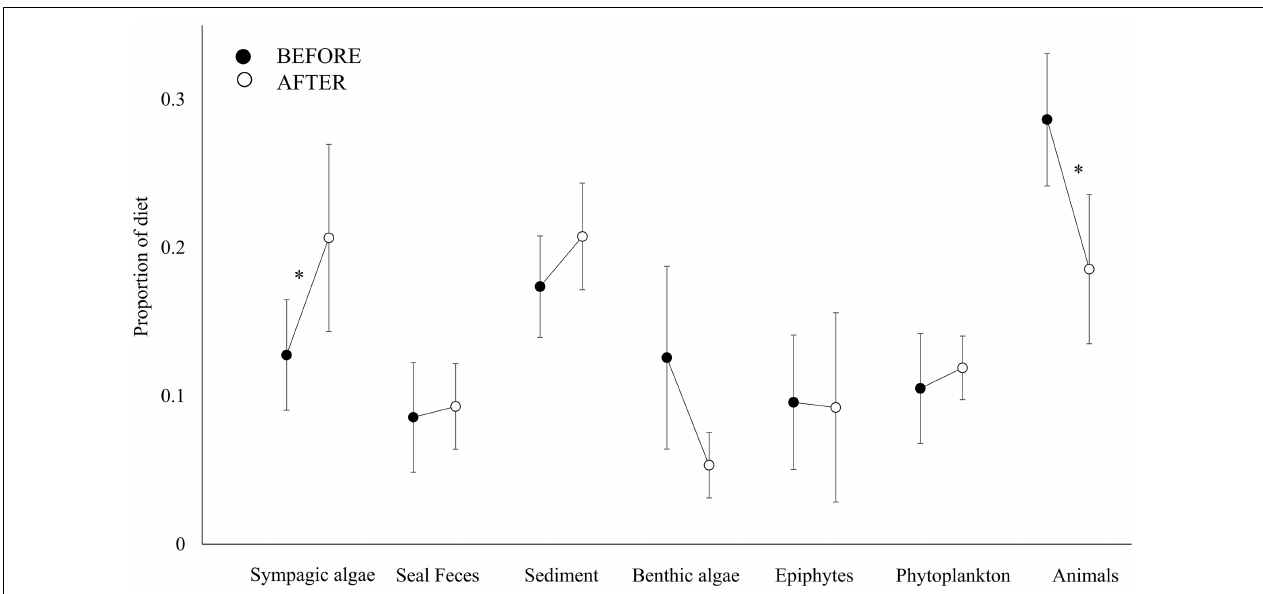
FIGURE 3 | Contribution of basal resources (Sympagic algae, Seal feces, Sediment, Benthic algae, Epiphytes and Phytoplankton) and animal-derived resources (Animals) to the diet BEFORE (full symbols) and AFTER (empty symbols). The proportional contribution of each item is reported as the mean ± SE. Superscript symbols (*) indicate a significant difference between periods (see also section “Results”).